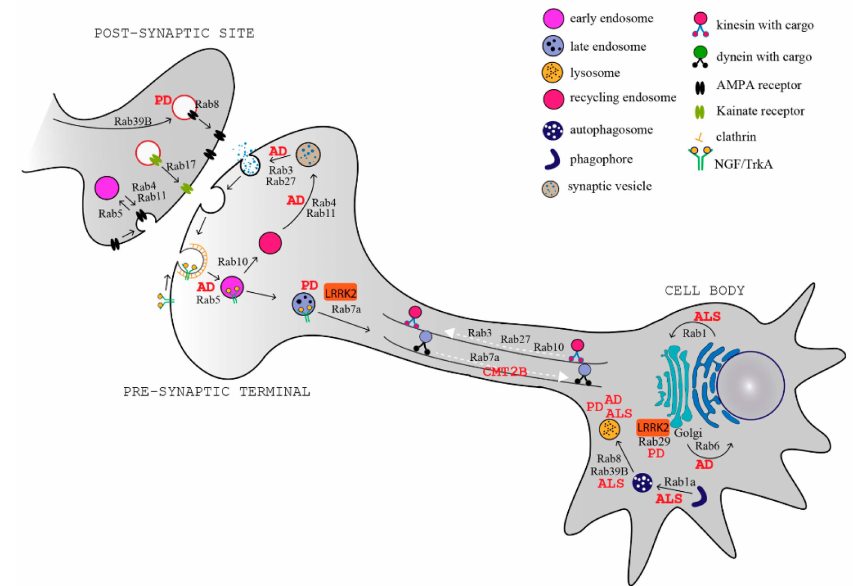
Figure 1. Rab proteins and transport pathways involved in neurodegenerative diseases. Schematic representation of a neuron and a post-synaptic terminal showing key Rab proteins and the tra ffi cking pathways that they regulate. The Rab-dependent processes that are altered in neurodegenerative diseases (indicated in red) are highlighted. AD: Alzheimer’s disease, PD: Parkinson’s disease; ALS: amyotrophic lateral sclerosis; CMT2B: Charcot–Marie–Tooth 2B; LRRK2: leucine-rich repeat kinase 2; NGF: nerve growth factor; TrkA: tropomyosin receptor kinase A; AMPA: α -amino-3-hydroxy- 5-methyl-4-isoxazolepropionic acid. Table 1. Rab proteins involved in neurodegenerative diseases. Rab Rab Alterations Associated with the Protein